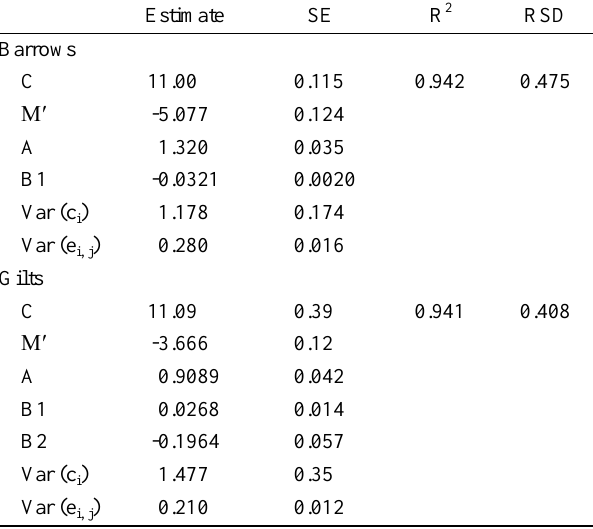
Table 8. Parameters for the Bridges Function fitted to daily ME